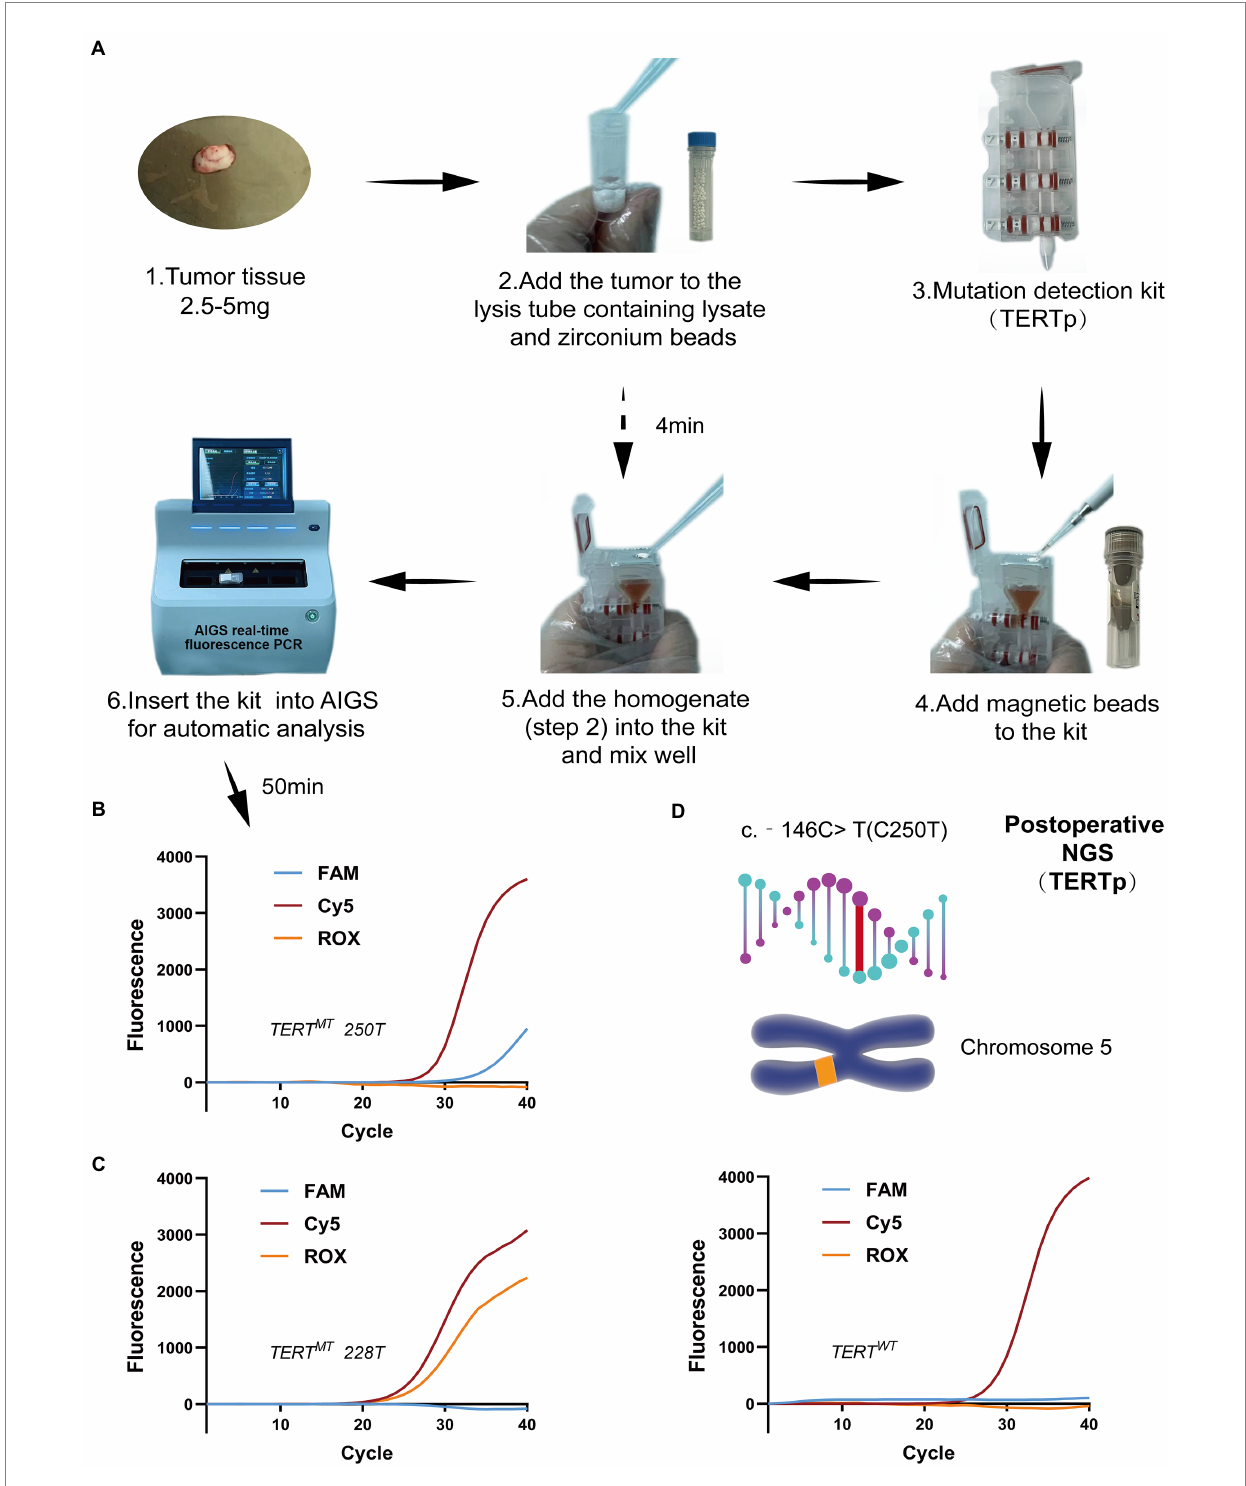
FIGURE 3 AIGS real-time fluorescence PCR was used for intraoperative molecular diagnosis (A) . Real-time fluorescence curve (B) represents TERTp C250T mutation (FAM and Cy5 showed S-type amplification). NGS was performed at the same time after operation. The results showed that the patient had TERTp C250T mutation (C) ; Panel (D) represents the meaning of the other two curves detected by AIGS. (Left): TERTp C228T mutation (ROX and Cy5 showed S-type amplification), (Right): TERTp wild type (Cy5 showed S-type amplification). FAM is the C250T probe, Cy5 is the GAPDH internal reference probe, and ROX is the C228T